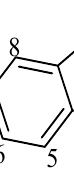
Figure 2. Structure of carbazole.